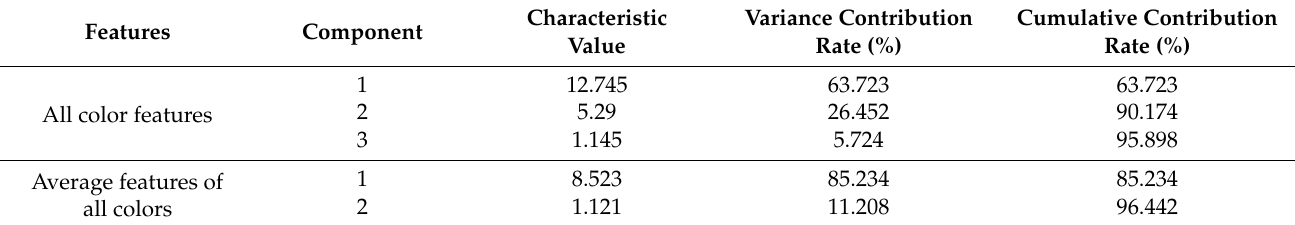
Table 1. The principal component eigenvalues, contribution rate, and cumulative contribution rate of all color features and all color average features.